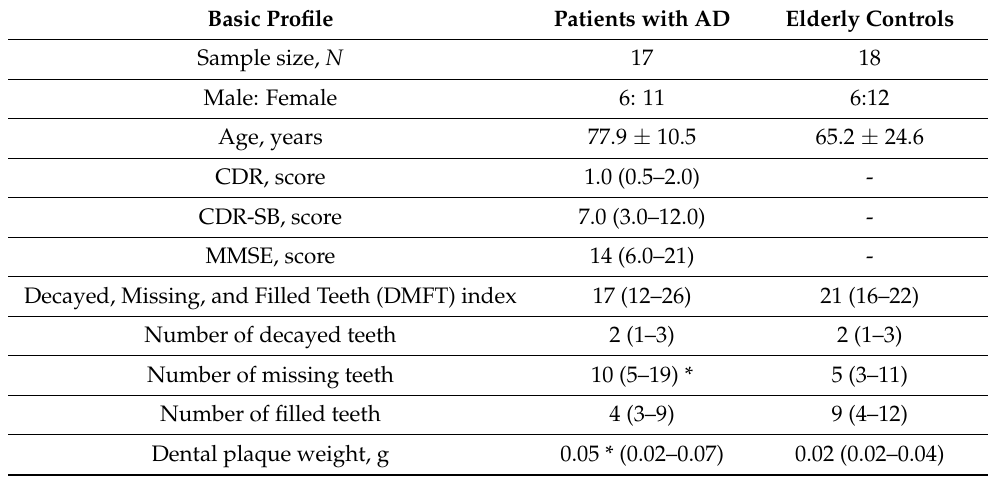
Table 1. Characteristics of patients with Alzheimer’s disease (AD) and elderly controls. Basic Profile Patients with AD Elderly Controls Sample size, N 17